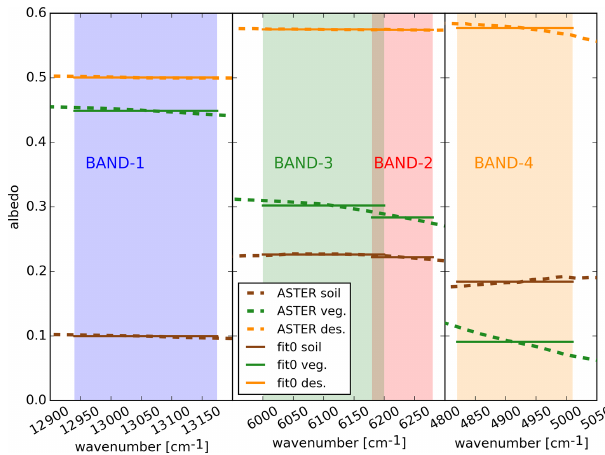
Figure 5. True spectral dependence of the three albedo models con- sidered in this work. Constant band-wise fits of these models are used